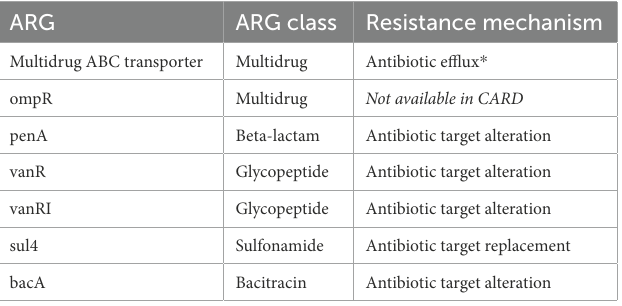
Resistance mechanisms were taken from the CARD database (Alcock et al., 2019). * Not available by name in CARD, but because the names include the word “transporter,” we assign the antibiotic efflux